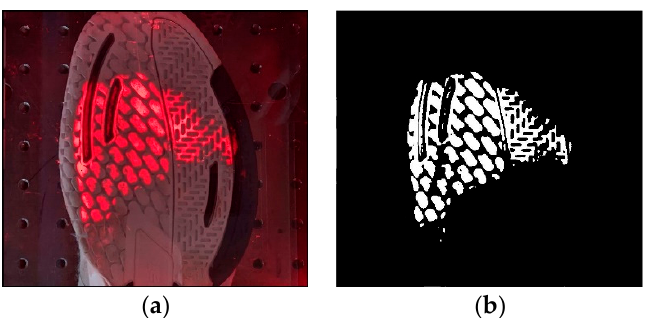
Figure 4. ( a ) A footprint image of the Babolat forefoot with a normal load of 1100 N; ( b ) A binary version of the footprint from which contact areas were calculated.